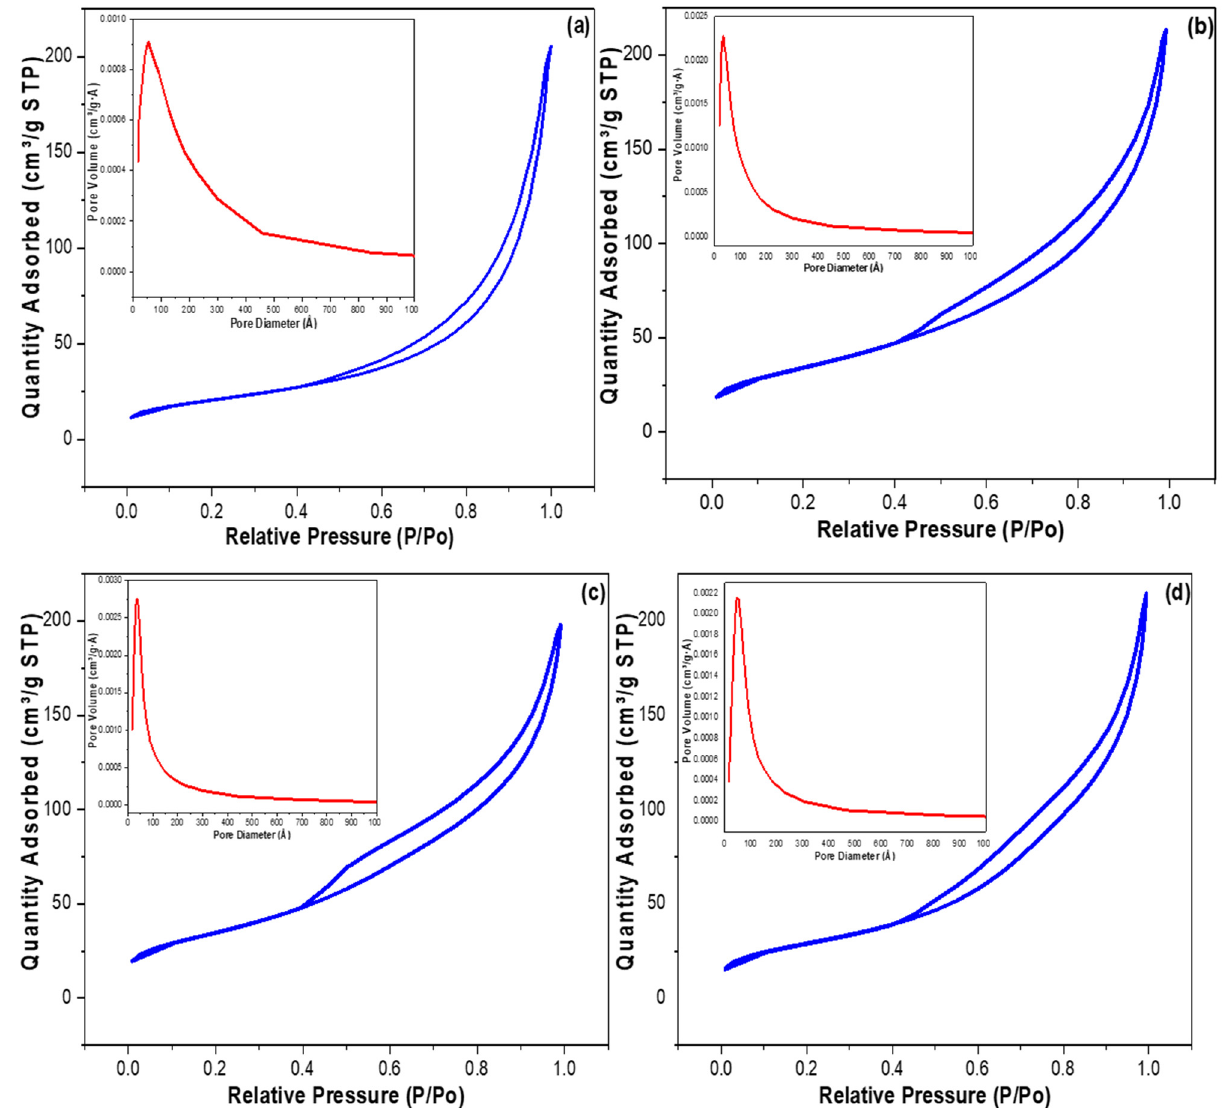
Figure 6. The nitrogen adsorption isotherms and pore size distribution results for ( a ) Al 2 O 3 nanopar- ticle, ( b ) Al 2 O 3 -CuO, ( c ) Al 2 O 3 -NiO, and ( d ) Al 2 O 3 -CoO Table 1. The surface characteristics of the prepared Al 2 O 3 , Al 2 O 3 -CuO, Al 2 O 3 -NiO, and Al 2 O 3 -CoO nanomaterials.